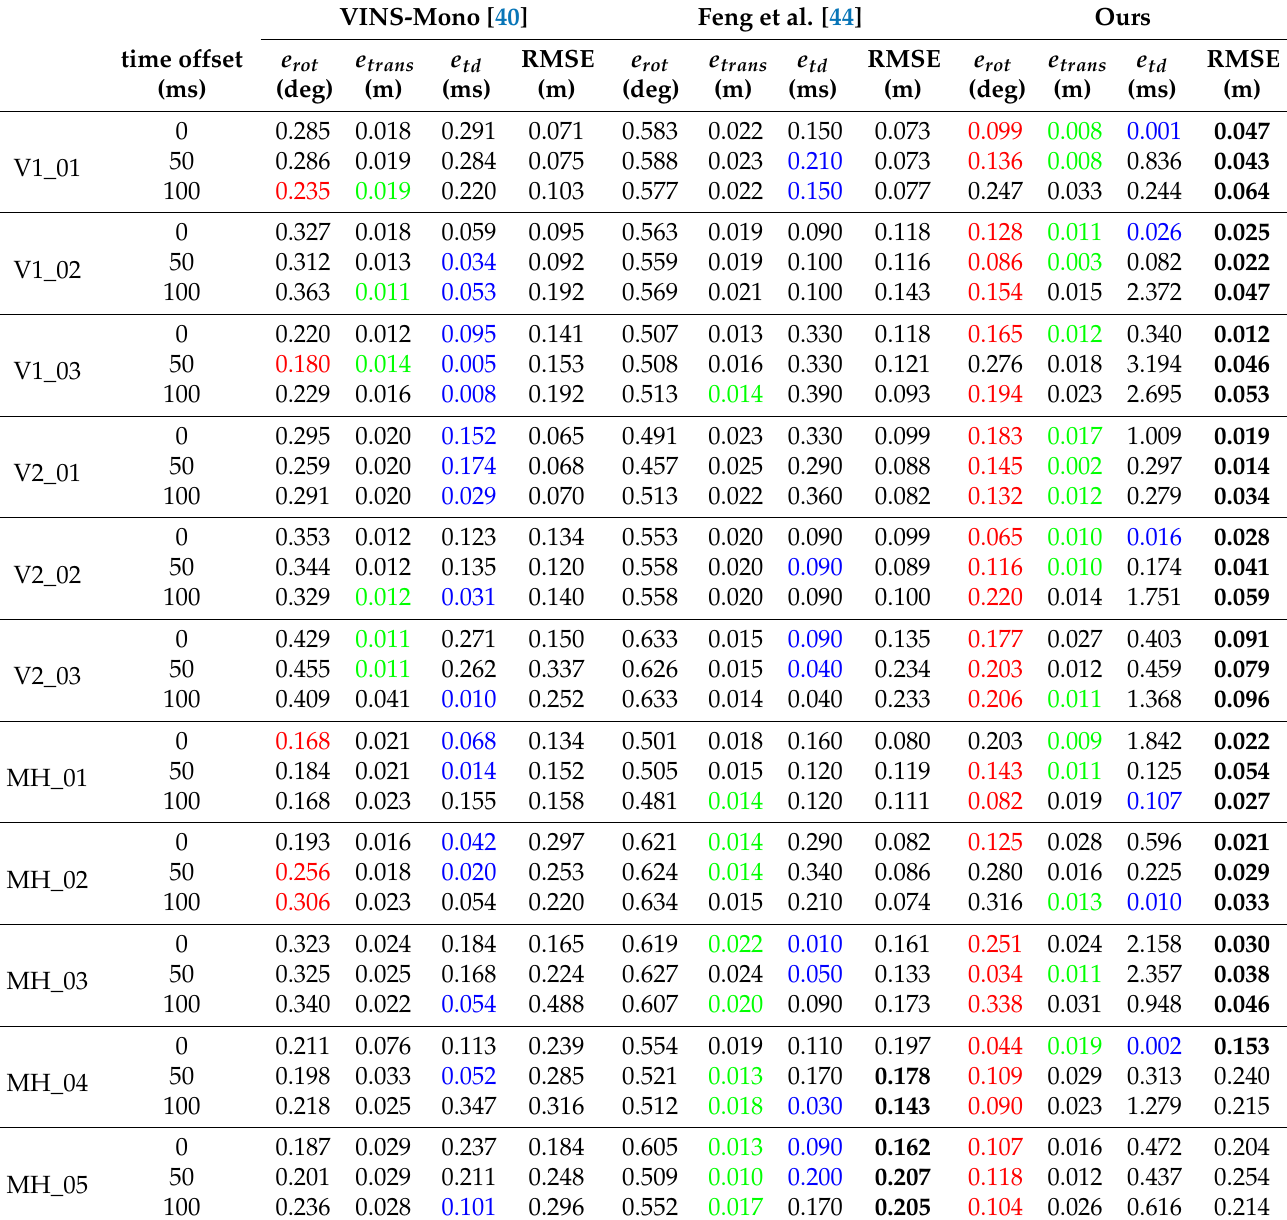
Table 3. Spatial-Temporal Calibration Errors and Keyframe Trajectory Accuracy on the EuRoC Dataset 1 . VINS-Mono [40] Feng et al. [44]